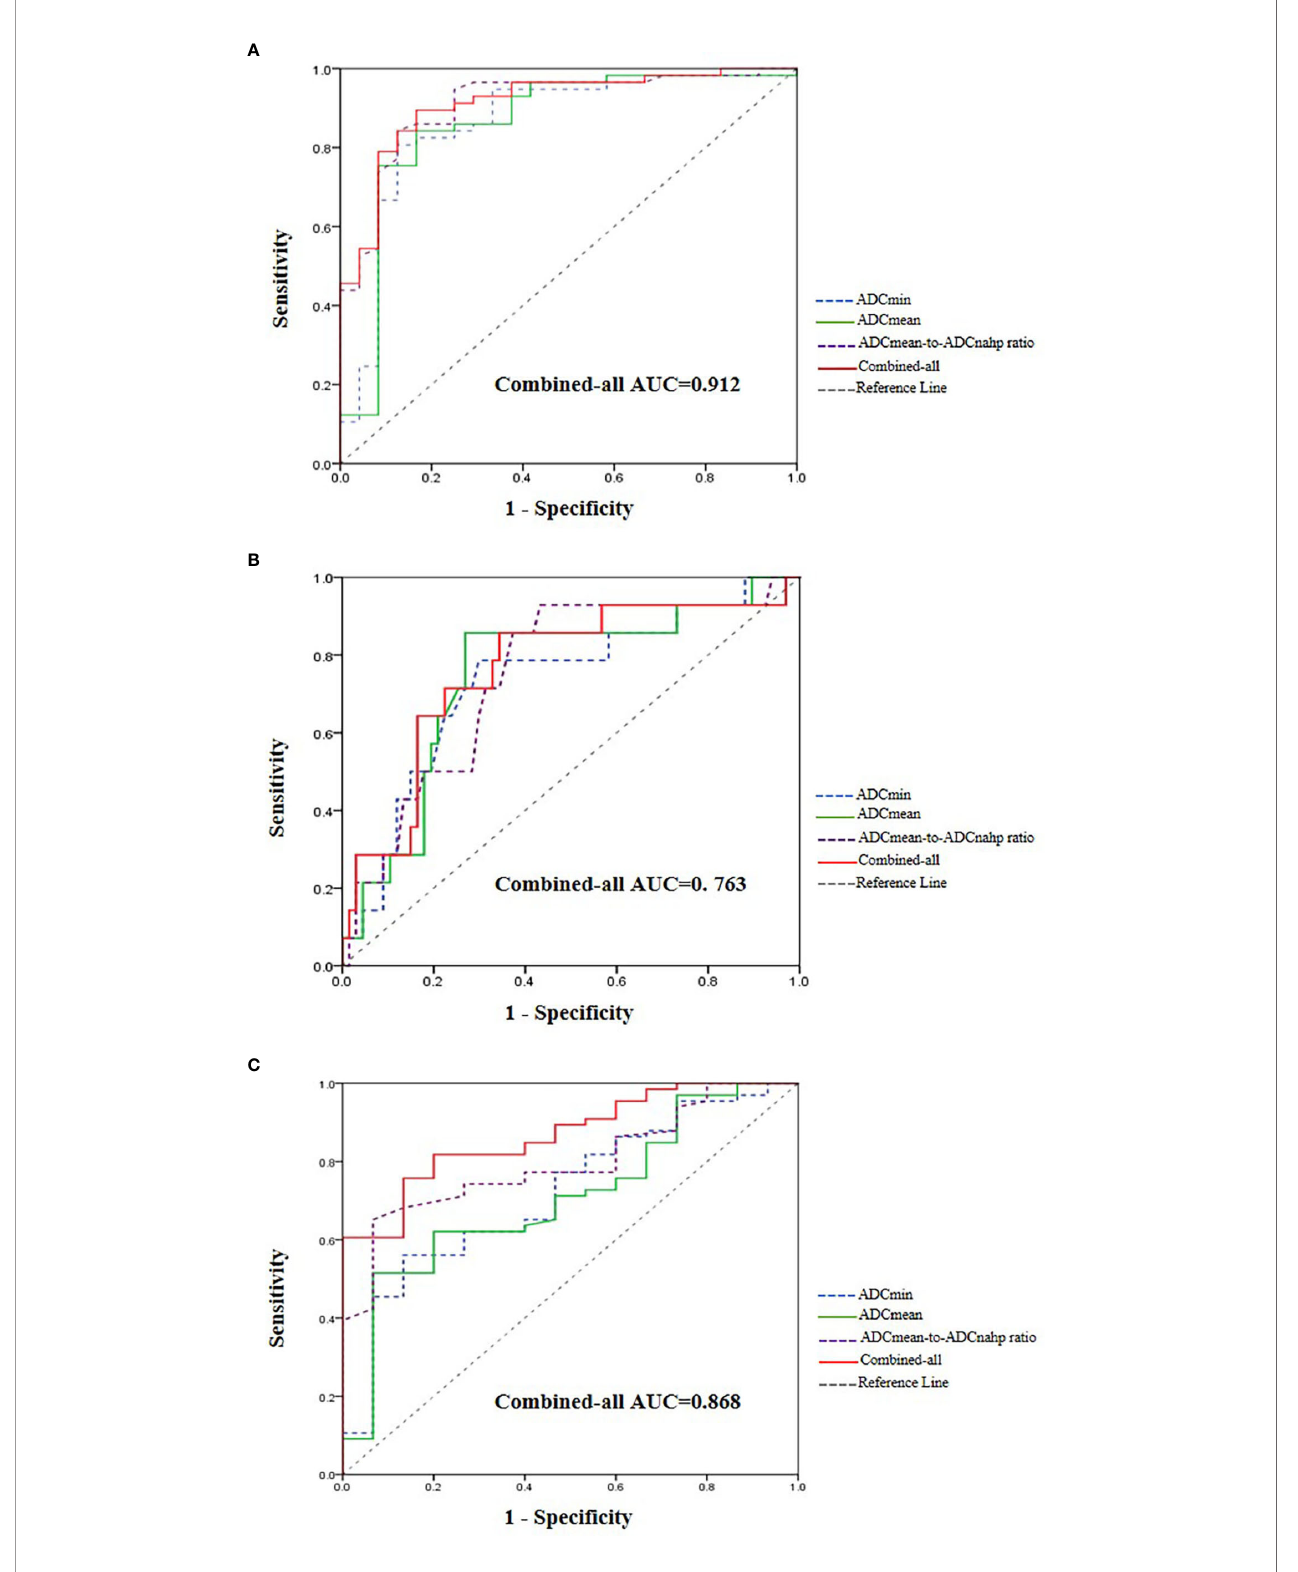
FIGURE 4 | Receiver operating characteristic curve and area under the curve for judging hepatocellular carcinoma (HCC) microvascular invasion (A) , tumor differentiation (B) , and Ki-67 expression (C)